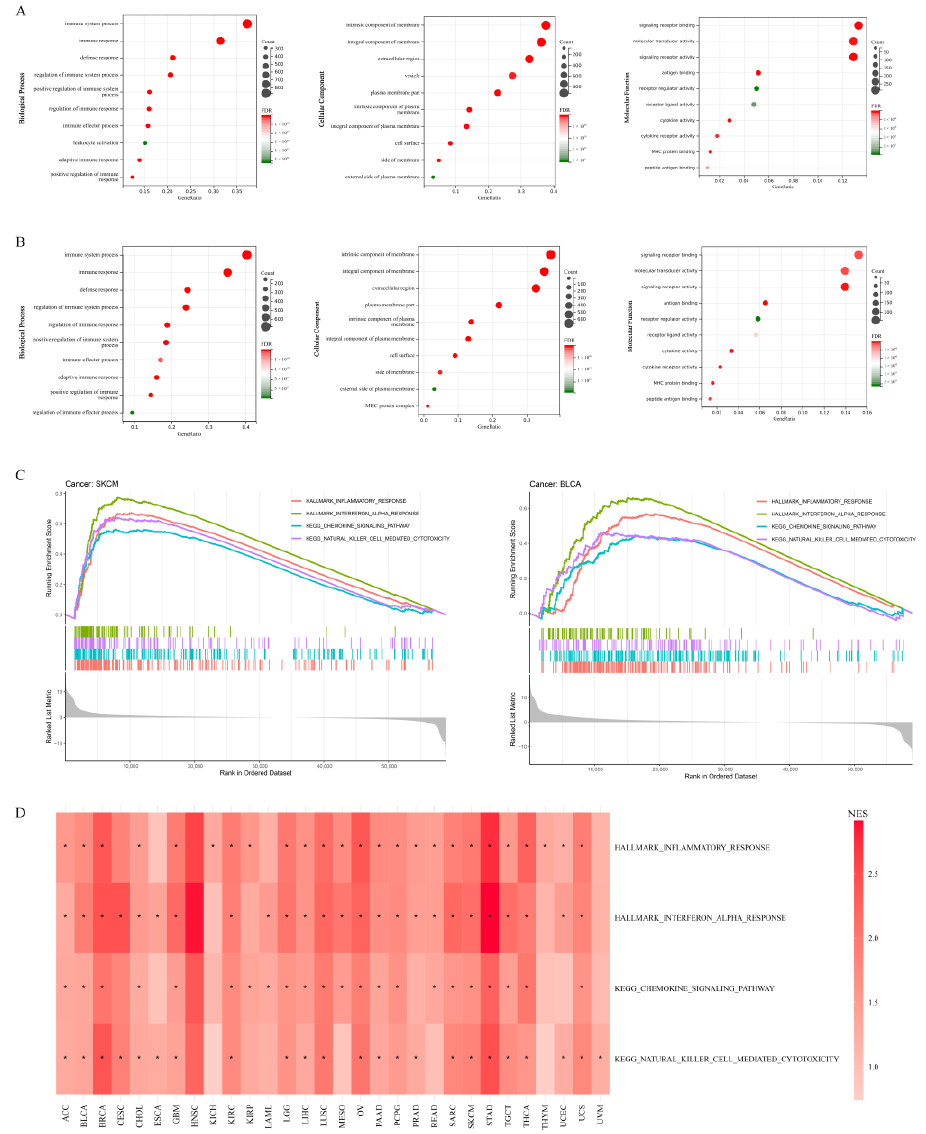
Figure 4. Functional enrichment analysis of APOL6 in cancers. ( A , B ) Gene ontology (GO) analysis: top ten terms of GO function analysis in melanoma ( A ) and urothelial cancer ( B ) patients are shown. ( C ) Gene set enrichment analysis (GSEA) of the KEGG pathway and HALLMARK pathway in melanoma and urothelial cancer: Four pathways associated with the immune response to immuno- genic cell death are shown. ( D ) Normalized enrichment scores (NESs) of the four pathways from GSEA across pancancer. * p <